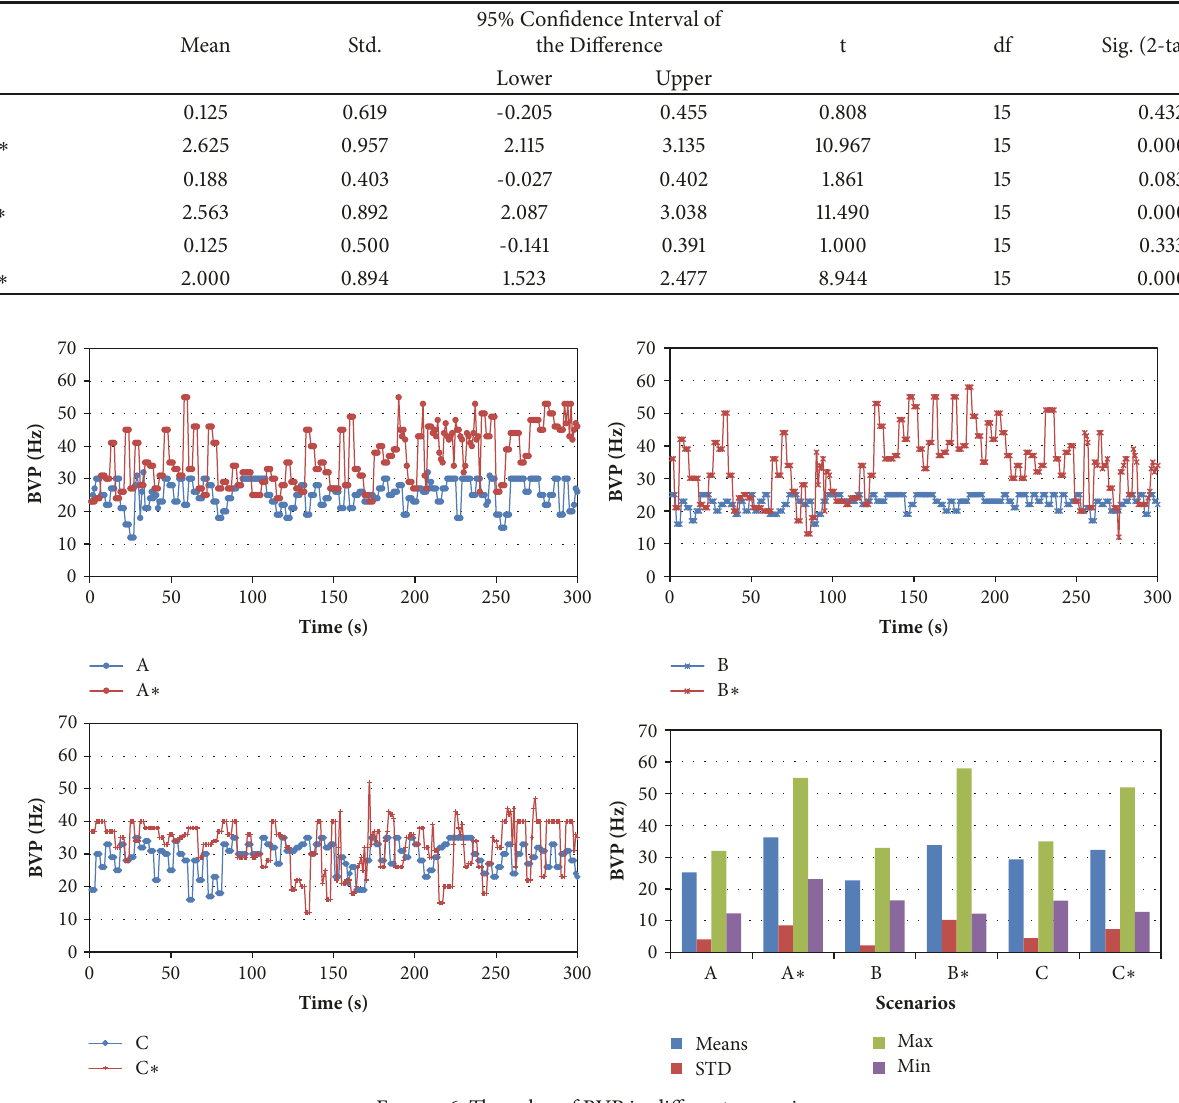
Figure 6: The value of BVP in different